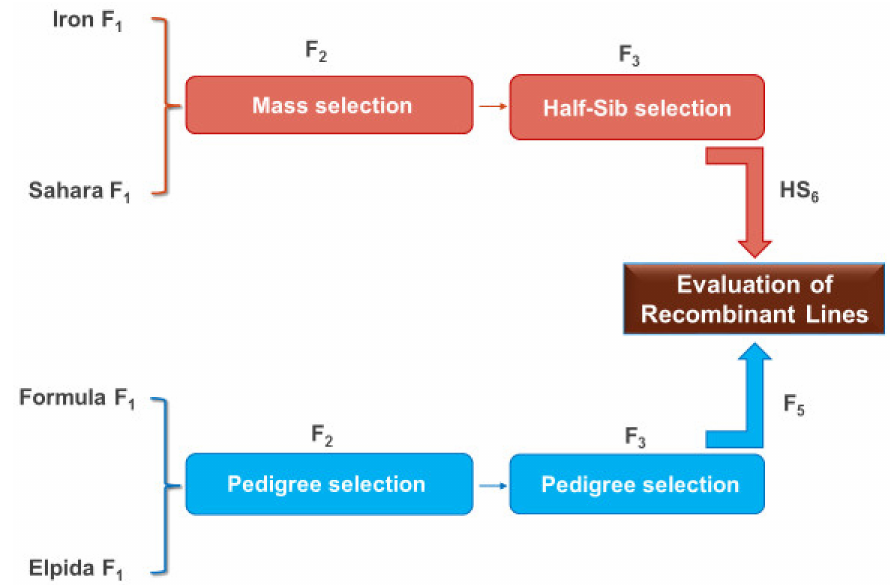
Figure 1. Breeding process applied for the production of new recombinant